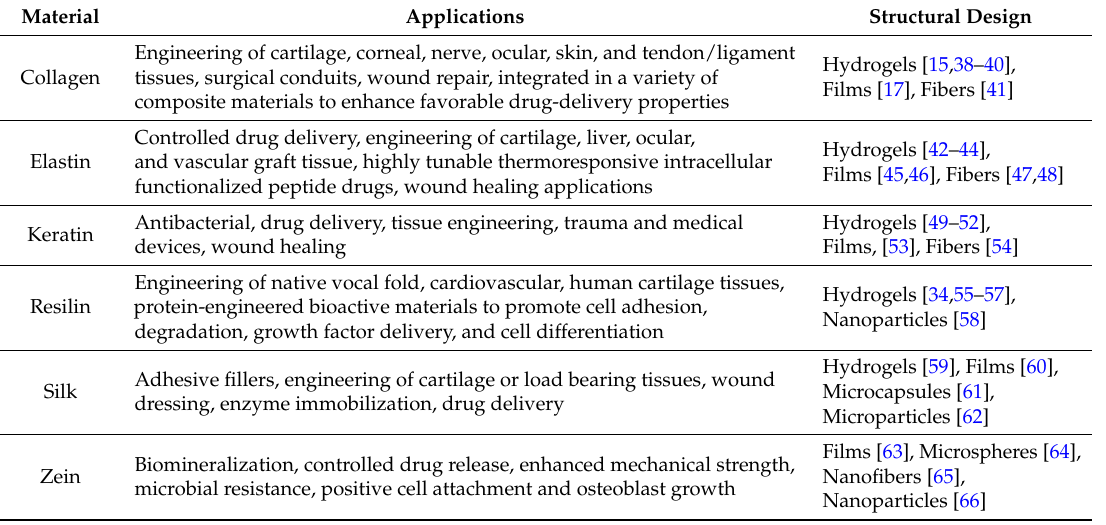
Table 1. Biomedical applications of protein biomaterial and their structural